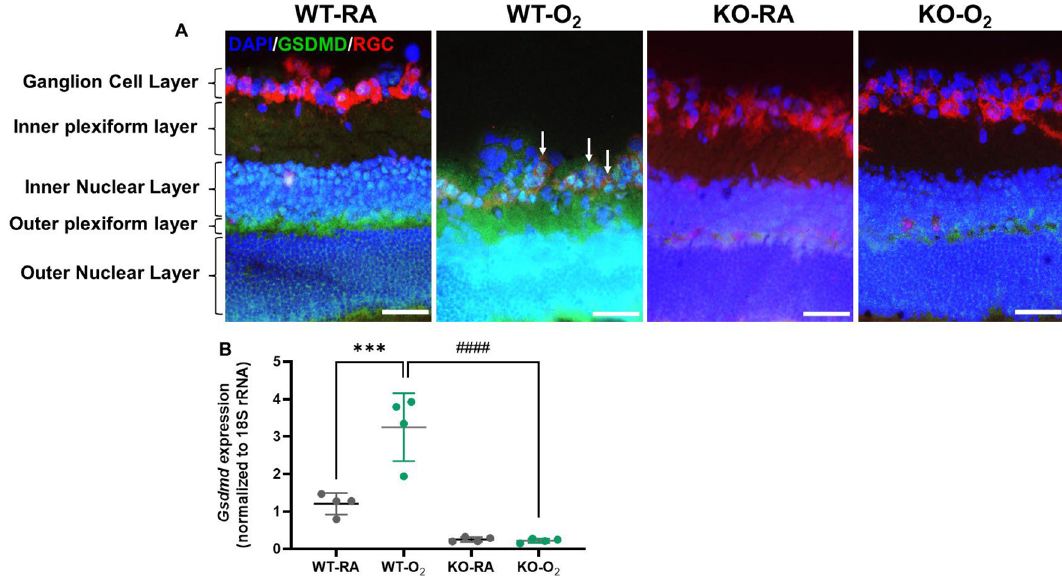
Figure 6. GSDMD expression in the retina. ( A ) Double immunofluorescence staining for GSDMD (green signals) and RBPMS (an RGC marker, red signals) and DAPI nuclear stain (blue signals) were performed to assess GSDMD expression and colocalize it with RGC. GSDMD was detected in the outer plexiform layer in the WT-RA retinas. GSDMD expression was increased in the outer plexiform layer and ganglion cell layer with some colocalized in the RGC (white arrows, orange signals) in the WT-O 2 retinas. There was decreased GSDMD expression in the outer plexiform layers in KO-RA and KO-O 2 retinas. ( B ) qRT-PCR showed